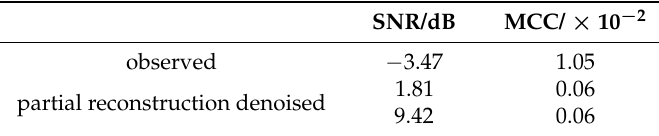
Table 2. Performance